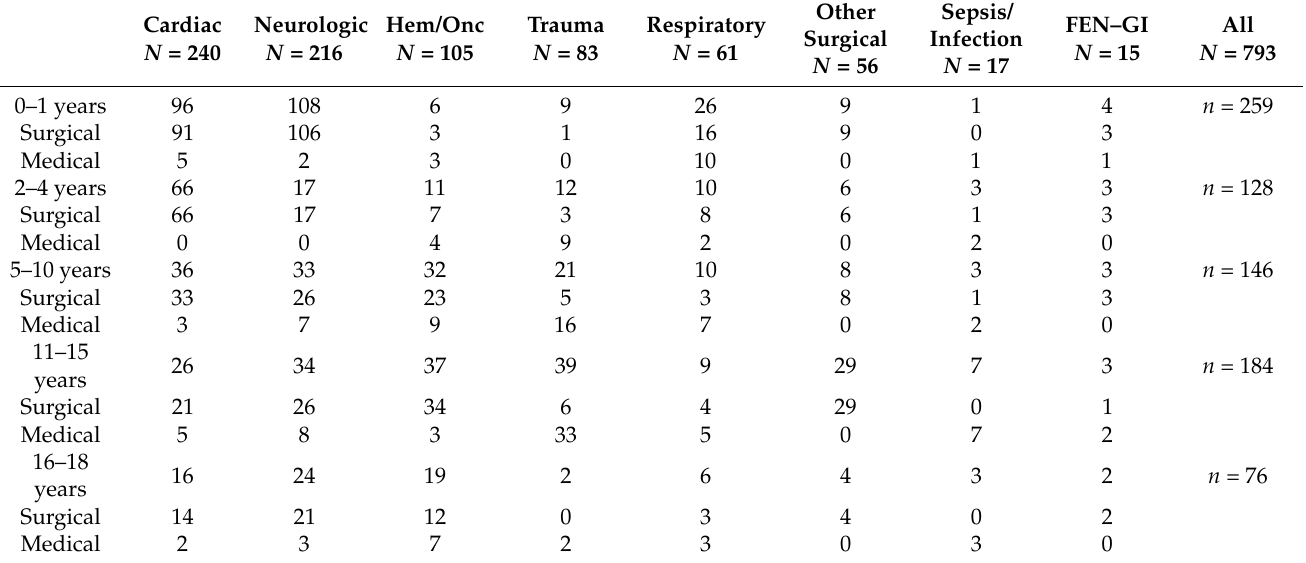
Descriptive data of children who received an opioid prescription by age and primary